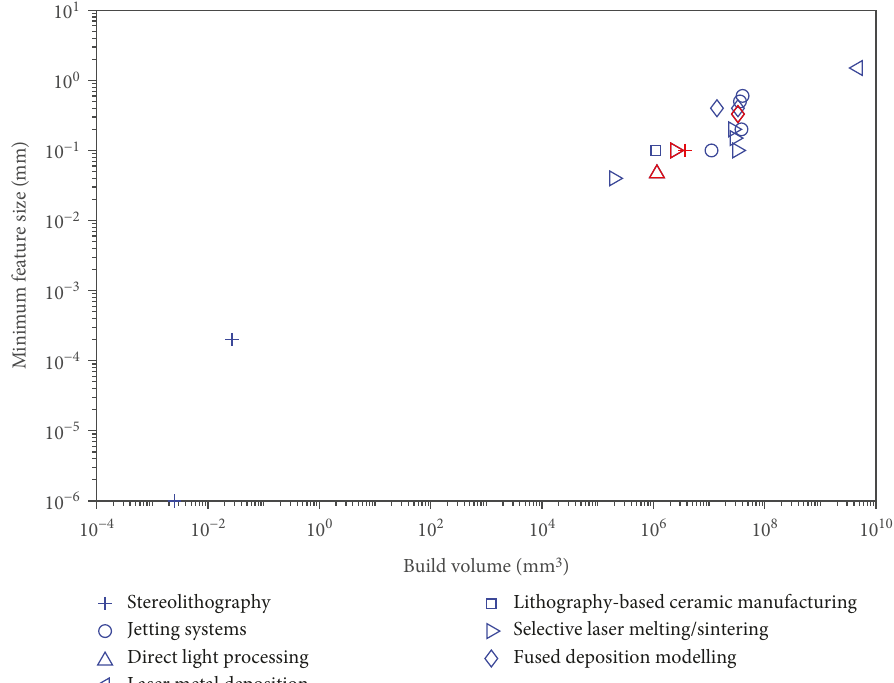
Figure 1: Build volume and minimum feature size for commercial additive manufacturing systems based on manufacturer data (the machines used in this research are identi fi ed by red